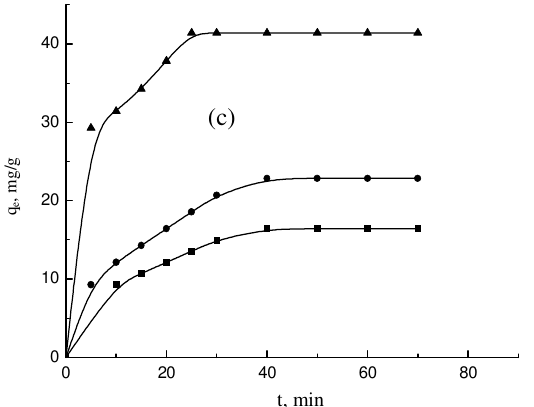
Figure 5. Influence of PEG (10000) concentration and temperature on adsorption kinetics. (a) 50 mg/L, (b) 200 mg/L, (c) 500 mg/L; ( ■ )5 °C, ( ● )25 °C, ( ▲ )45 °C